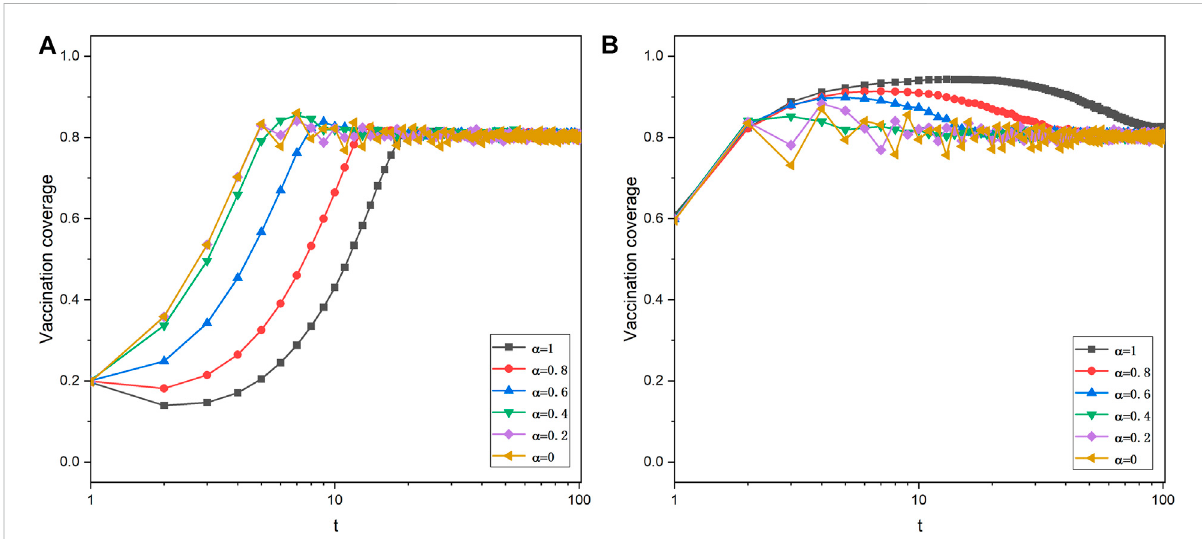
FIGURE 7 Time courses of vaccination coverage in the square lattice network. V 0 = 0.2 (A) and V 0 = 0.6 (B) . Depicted results are obtained for γ = 0.8, K = 0.1, C V = 0.3, and C H =